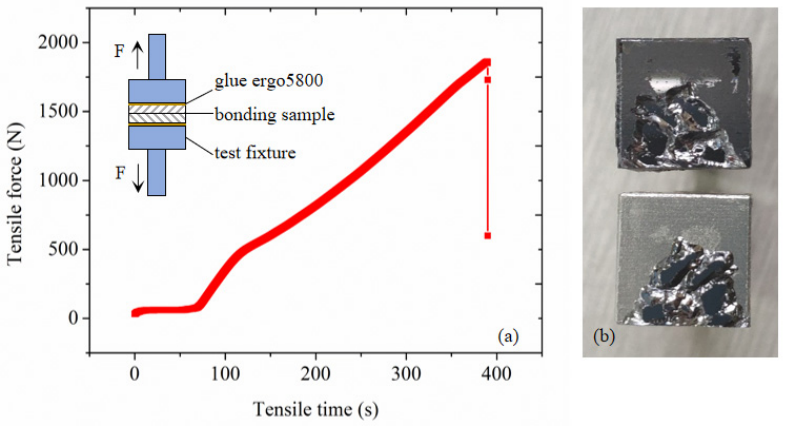
Figure 8. Tensile pulling testing. ( a ) The fracture force of the bonded sample. ( b ) The interfacial fracture samples after testing.